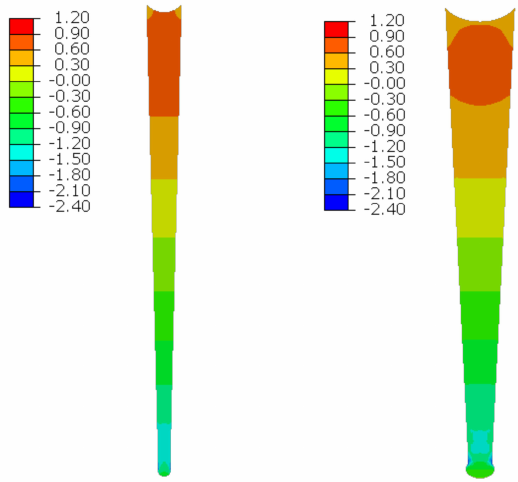
Figure 23. Deformations for scaling factor 1.0 and Cauchy stresses σ z in MPa for total load level. The width of the gap is equal to 1.0 cm, left graphic, and 2.0 cm, right graphic.